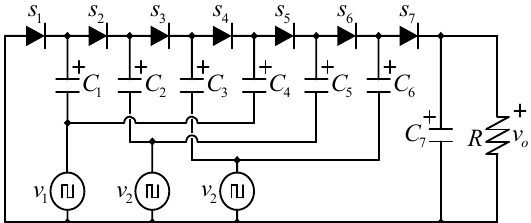
Figure 7. A multiple auxiliary input SC voltage multiplier.